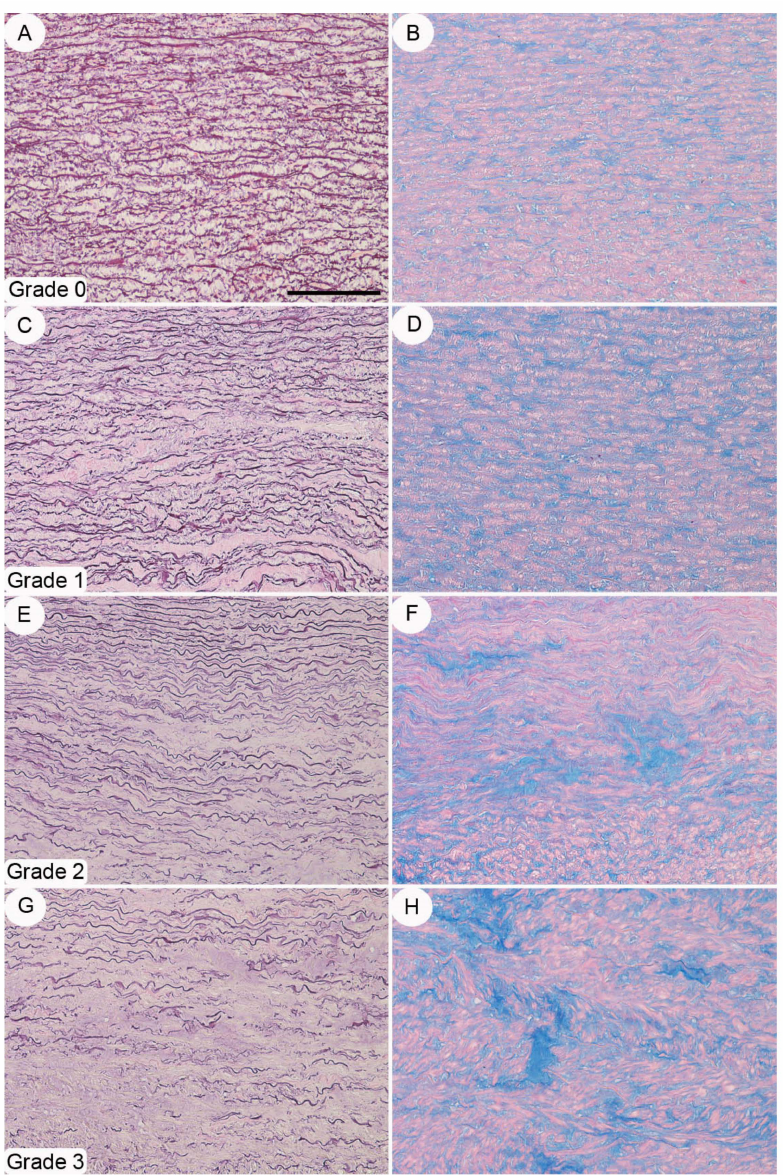
Figure 5. Aortic elastic fiber component disruption grading. ( A , B ), Grade 0 characterized by a normal distribution of the elastic fibers belonging to the aortic tunica media and no alcianophilic bluish accumulations. ( C , D ). Grade 1 with fragmentation of single elastic fibers and alcianophilic material still within the normal limits. ( E , F ). Grade 2 with fragmentation of adjacent elastic fibers and mild accumulation of alcianophilic material. ( G , H ). Grade 3 characterized by diffuse disruption of elastic fibers and moderate-to-severe accumulations of alcianophilic material. Staining. ( A , C , E , G ): Weigert’s elastic stain; ( B , D , F , H ): alcian blue stain. Original magnification. A–H: × 20 (bar is 150